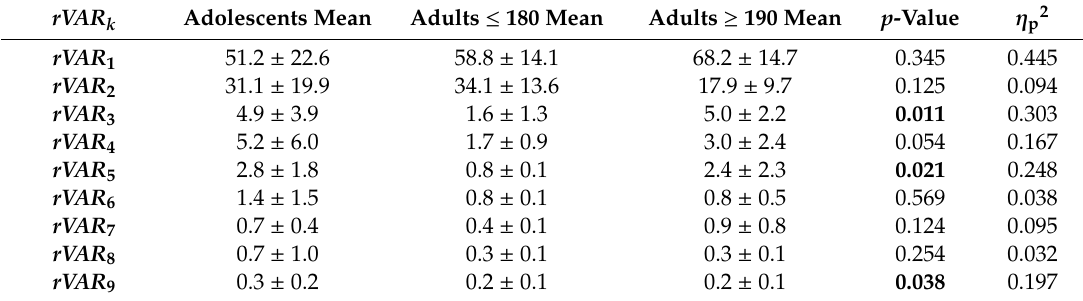
Table 5. Group di ff erences of rVAR k in the di ff erent movement components during the eyes-open trial are presented. On the left, means ± SD of the adolescents and smaller and taller adults are shown. On the right, p -values resulting from the Kruskal–Wallis tests can be seen, bold p -values indicate p < 0.05, which, however, did not meet the threshold of significance after correction. E ff ect sizes are displayed as η p2 (partial